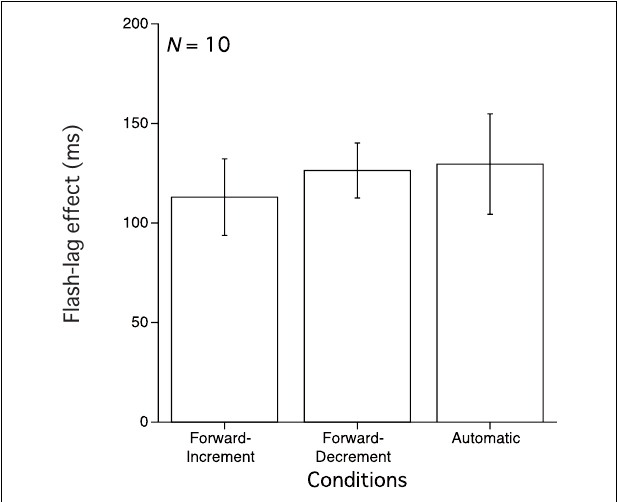
FIGURE 3 | Results of Experiment 2. Mean and SE of the 50% threshold for the three conditions.